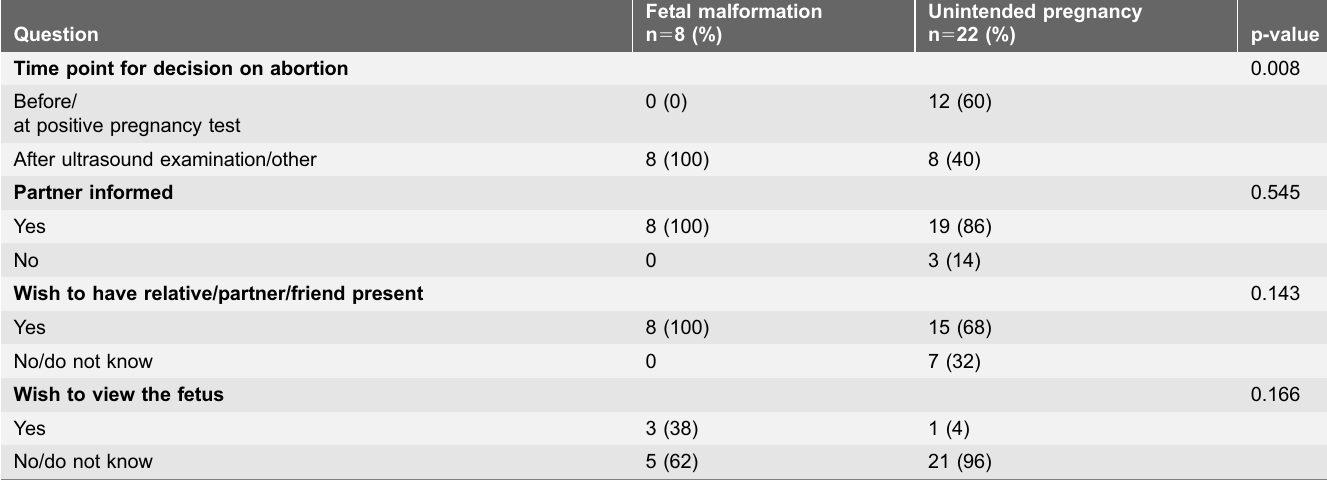
did not want to see the fetus or did not know if they would want to do so (Table 4). Half of the women undergoing abortion for fetal malformation chose to view the fetus after the abortion compared with 39% of women with unintended pregnancy (Table 5). The women expressed similar feelings/emotions and this was largely irrespective of the reason for having an abortion but with some differences. Women undergoing abortion for fetal anomaly had chosen pain, anger and powerlessness more frequently than women with unintended pregnancy. Relief was expressed by half of the women with unintended pregnancy compared with none in the other group (Table 6). Table 4. Responses to the